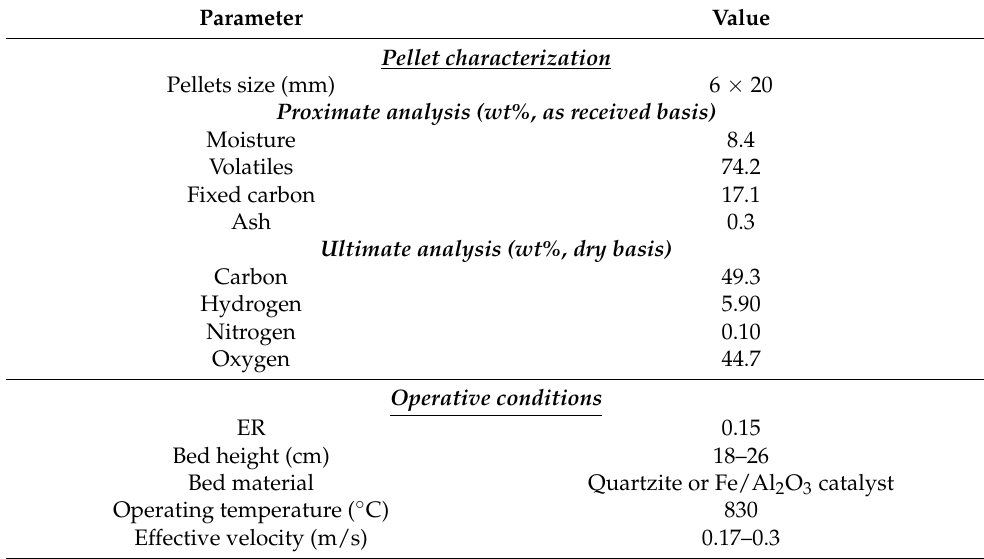
Table 1. Spruce wood pellet characterization and experimental conditions used for both standard and enhanced gasification